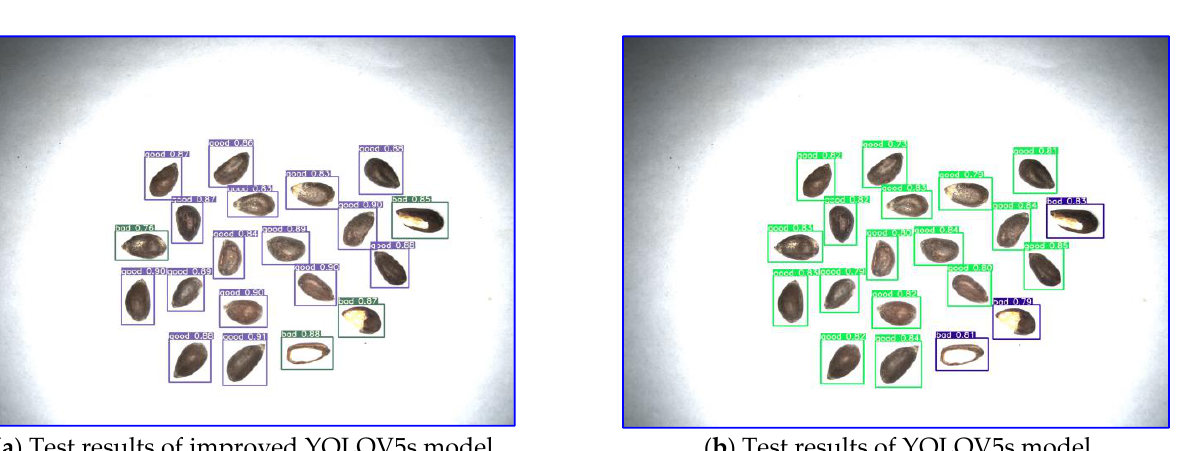
Figure 12. Different model misclassification cases.